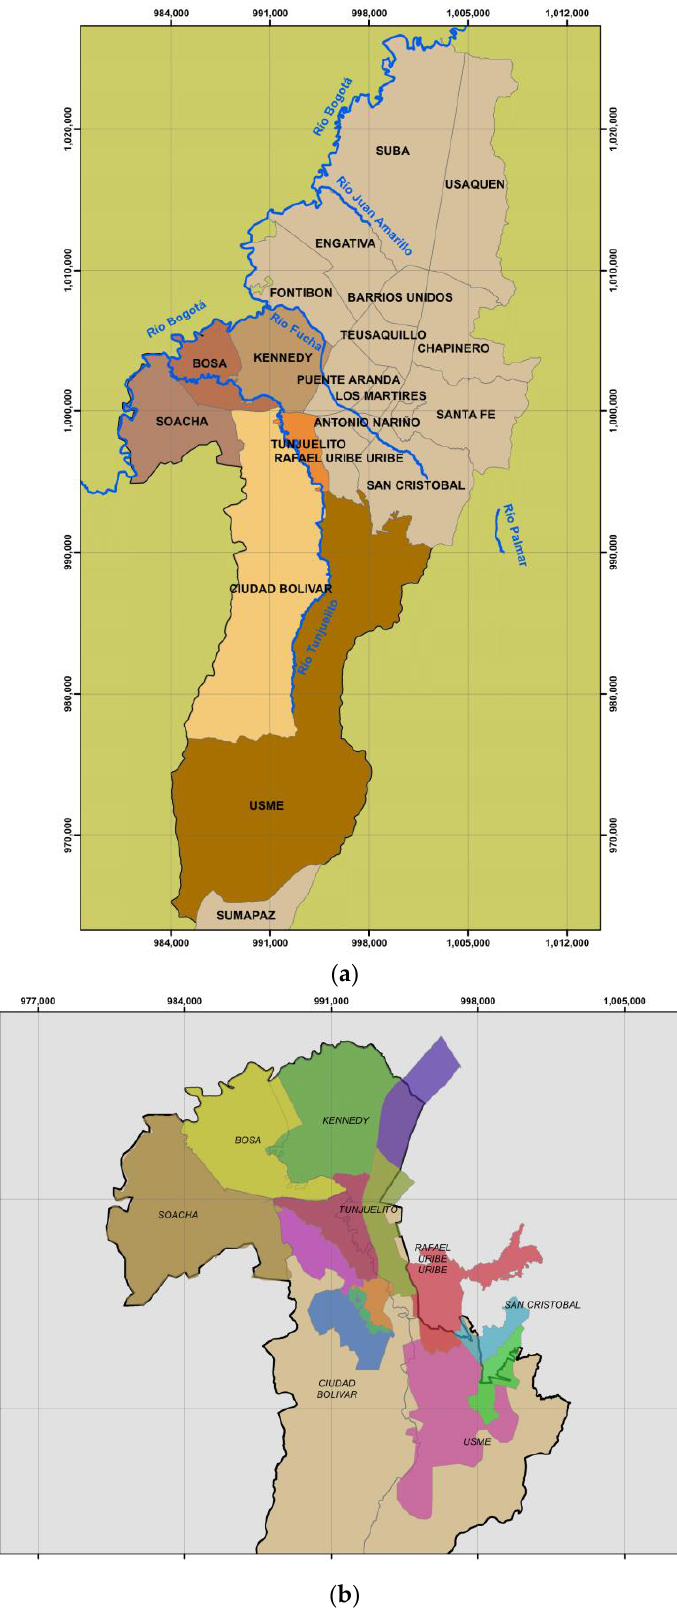
Figure 1. ( a ) Map of Bogotá by localities and Soacha; ( b ) Hydraulic sectors and localities to be ana- lysed.